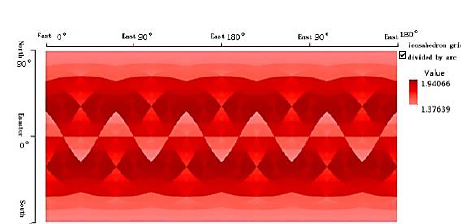
Figure 7. The planar distribution of octahedron grid divided by lonlat